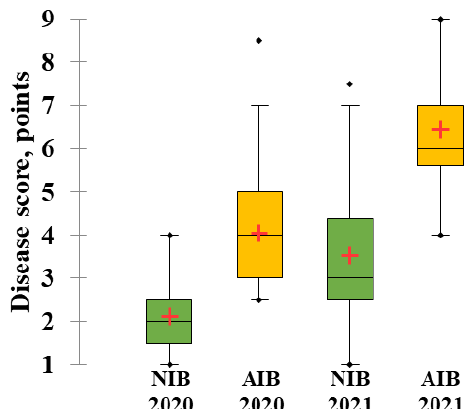
Figure 1. Boxplots showing the variation of the snow mold damage of rye genetic resources, in 2020 and 2021, under a natural infection background (NIB, green boxes) and an artificially-enriched infection background (AIB, yellow boxes). The boxplots show the interquartile range and the whiskers—minimum and maximum values. In each boxplot, the median is shown as a thick horizontal line, and the mean value is a cross. “ (cid:7) ” shows an outlier that is outside the boxplot whiskers and significantly different from the rest of the dataset.